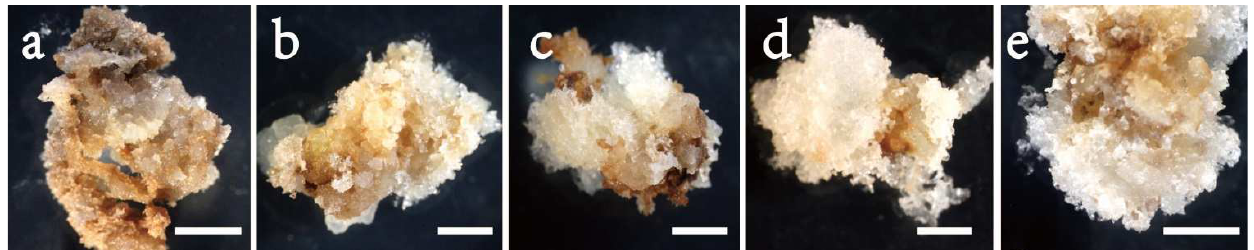
Figure 3. Initiation of embryogenic cell mass of provenance F1 in Picea pungens SE under various 6-